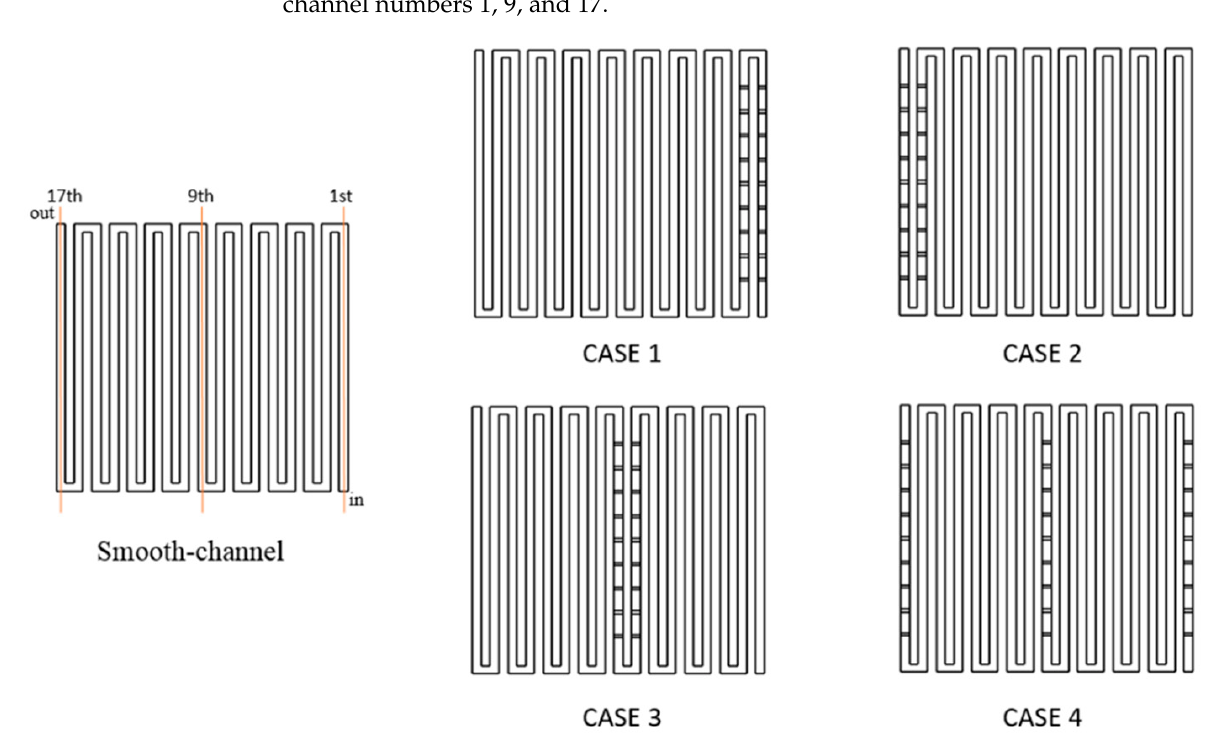
Figure 1. 3D modeling of a VRFB for serpentine flow channel.